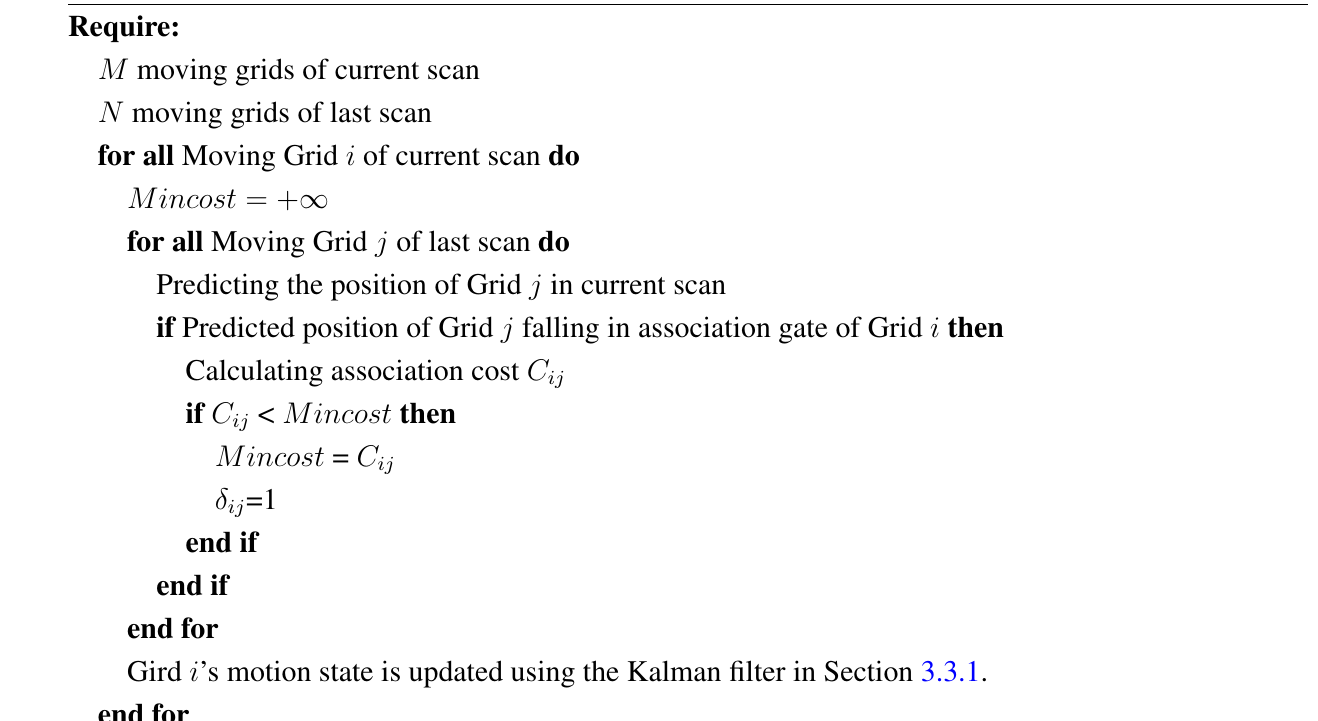
Algorithm 2 Relaxation of the linear integer assignment problem